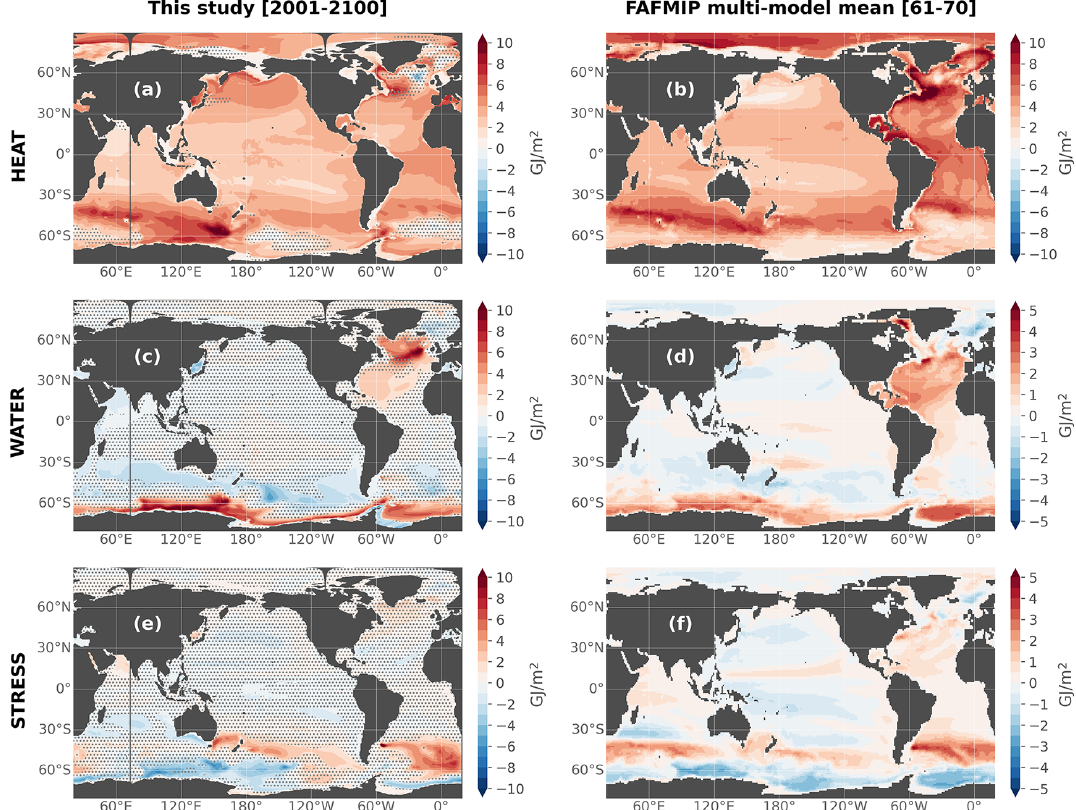
Figure 14. Vertically integrated ocean heat content anomalies in the HEAT, WATER and STRESS experiments in this study (a, c, e) and in the FAFMIP multi-model mean of Couldrey et al. (2021) ( b , d , f , which correspond to the data in their Fig. 6a–c). The mean is performed over 10–12 global climate models (see details in Couldrey et al., 2021). Anomalies are averaged over the period 2001–2100 for this study and years 61–70 for the FAFMIP simulations. In (a) , (c) and (e) , stipples indicate where the anomaly is lower than twice the interannual standard deviation of the CTL